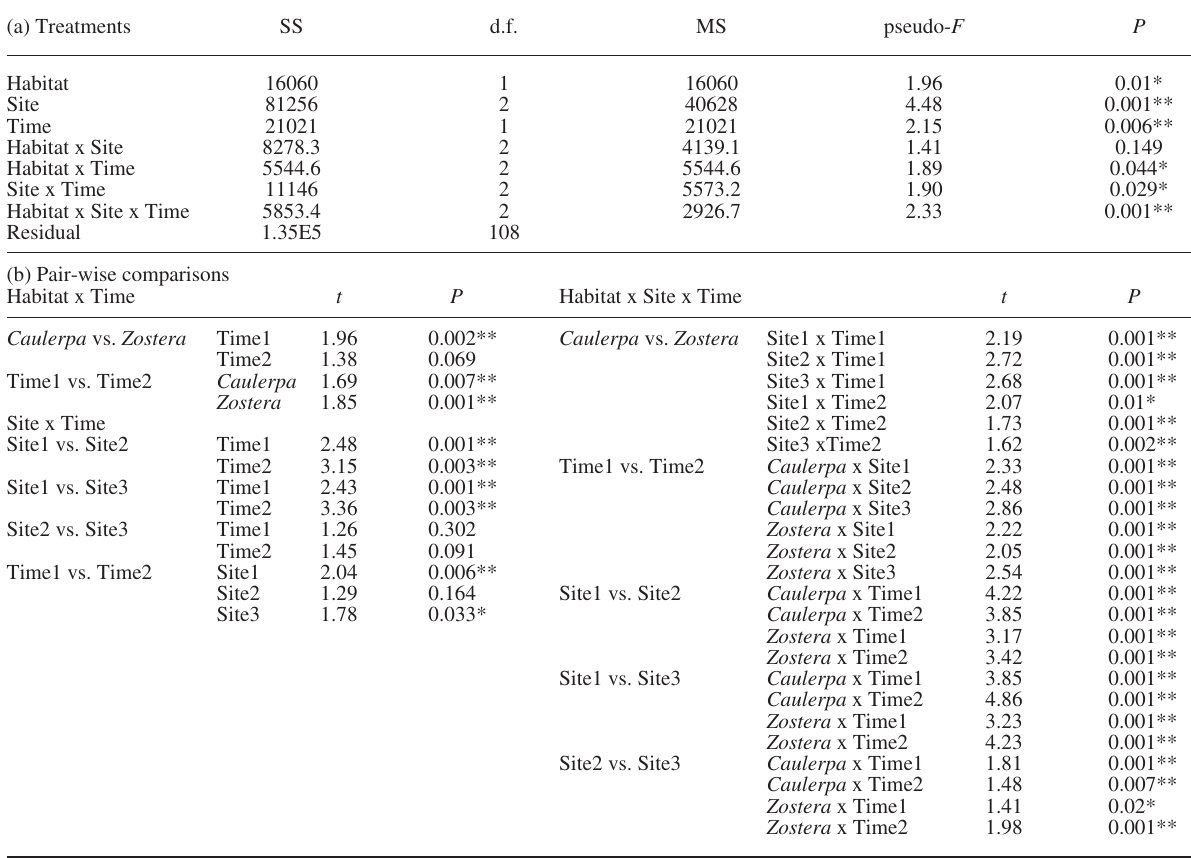
Table 2.– Results of (a) 3-factor PERMANOVA testing for differences in epiphyte composition, and (b) pair-wise comparisons test for the significant terms. Significant differences are indicated: * p < 0.05, ** p < 0.01, ***p < 0.001. (a)